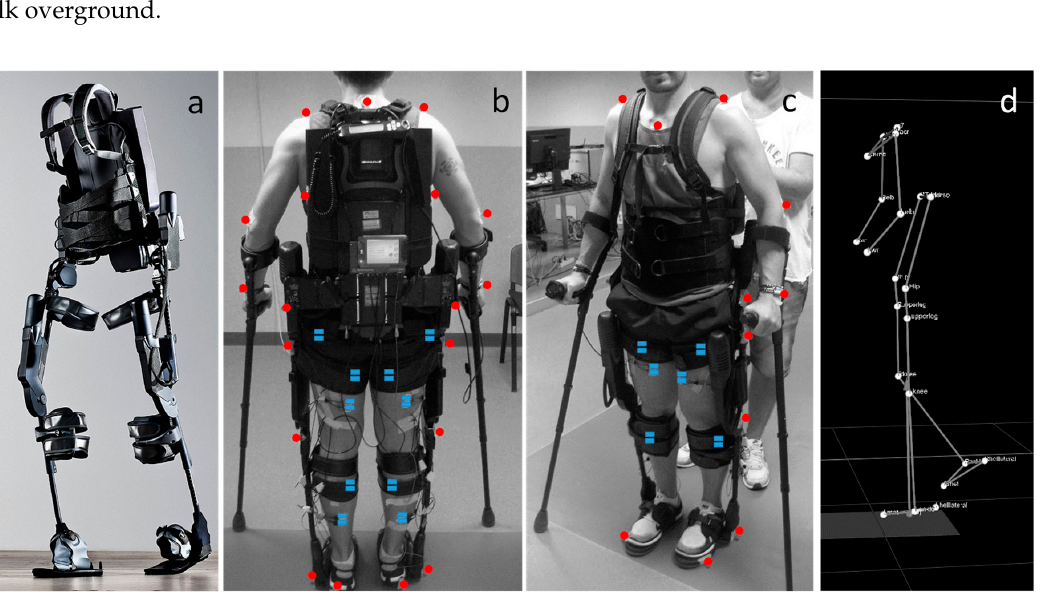
Table 1. Healthy subject’s data; Y: years, M: male, F: female.